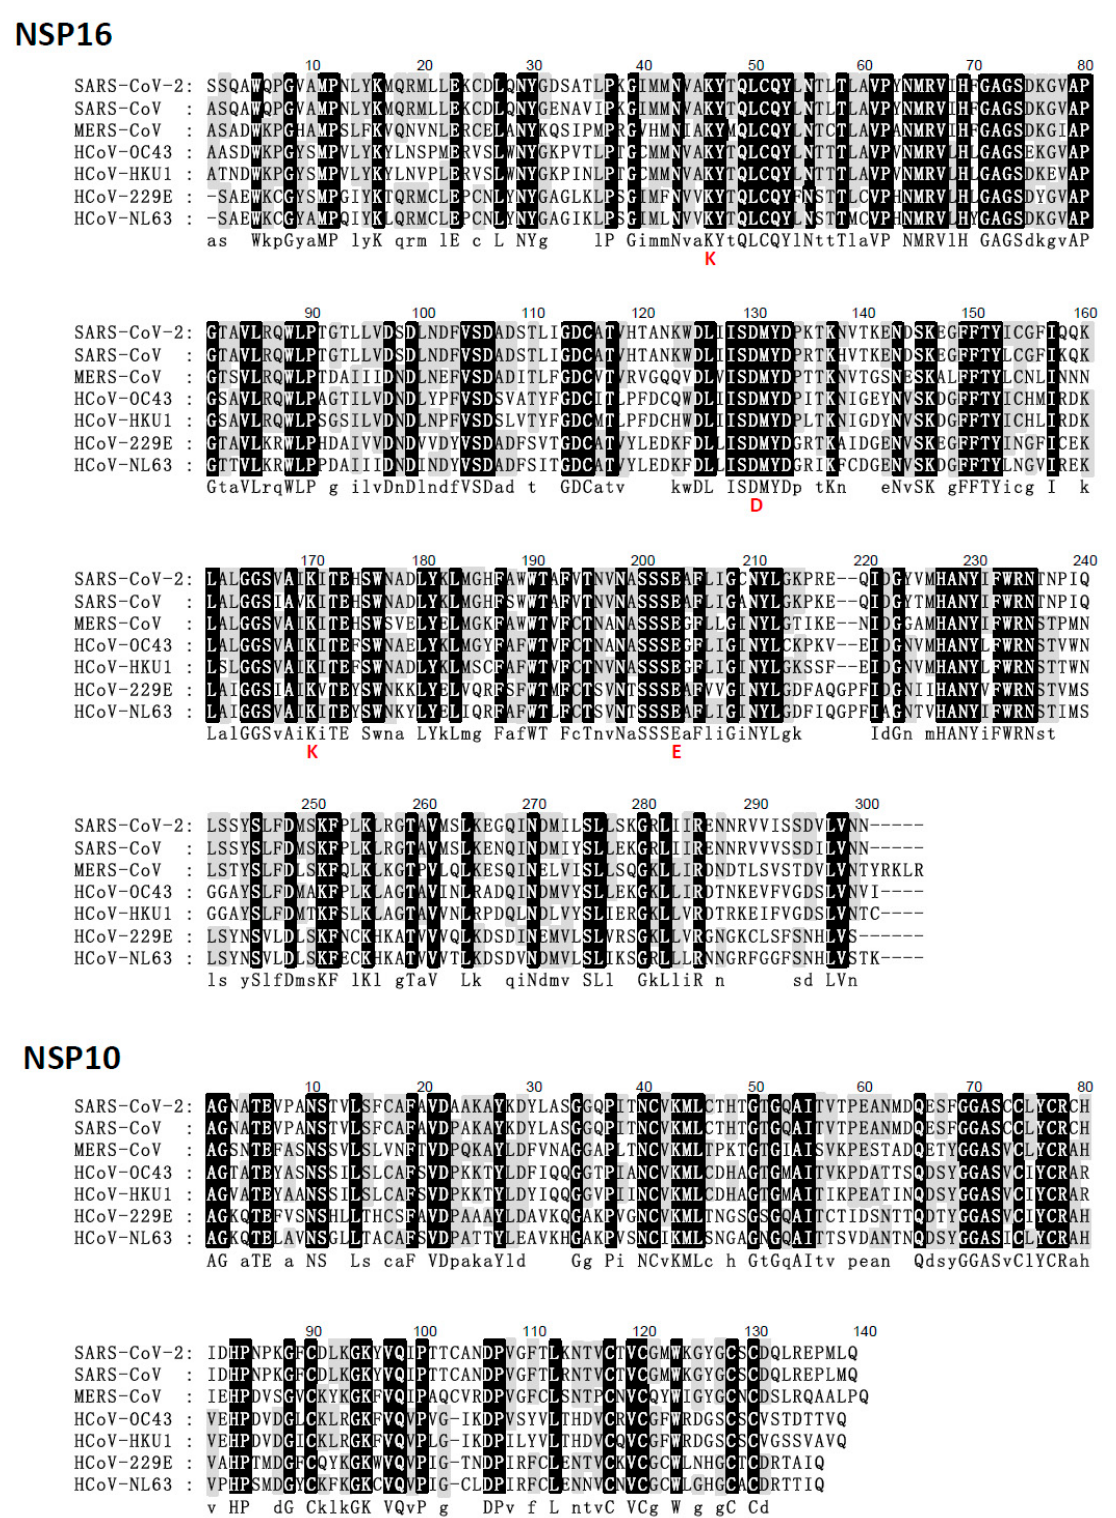
Figure 3. Multiple sequence alignment of the NSP16/NSP10 of SARS-CoV-2 with other human coronaviruses. Human coronaviruses NCBI Reference Sequence Database (RefSeq) sequences from GenBank accession numbers for protein sequence alignment analysis are as follows (http://www.ncbi.nim.nih.gov/genebank/) (accessed on 8 January 2021): NC_045512 (SARS-CoV-2), NC_004718 (SARS-CoV), NC_019843 (MERS-CoV), NC_006213 (HCoV-OC43), NC_006577 (HCoV-HKU1), NC002645 (HCoV-229E), and NC005831 (HCoV-NL63). The KDKE motif is shown in red